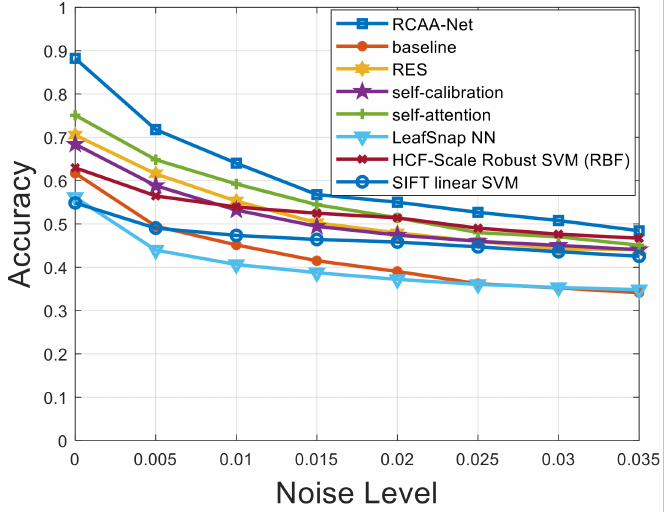
Figure 9. Recognition accuracy results when adding different levels of Gaussian noise + salt and pepper